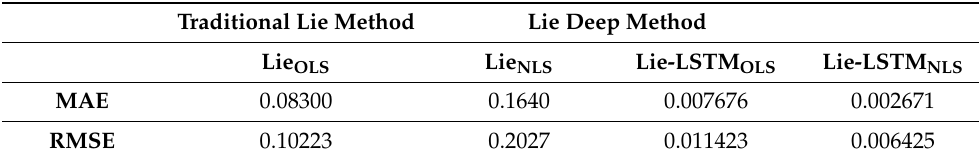
Table 5. In-sample forecast results.